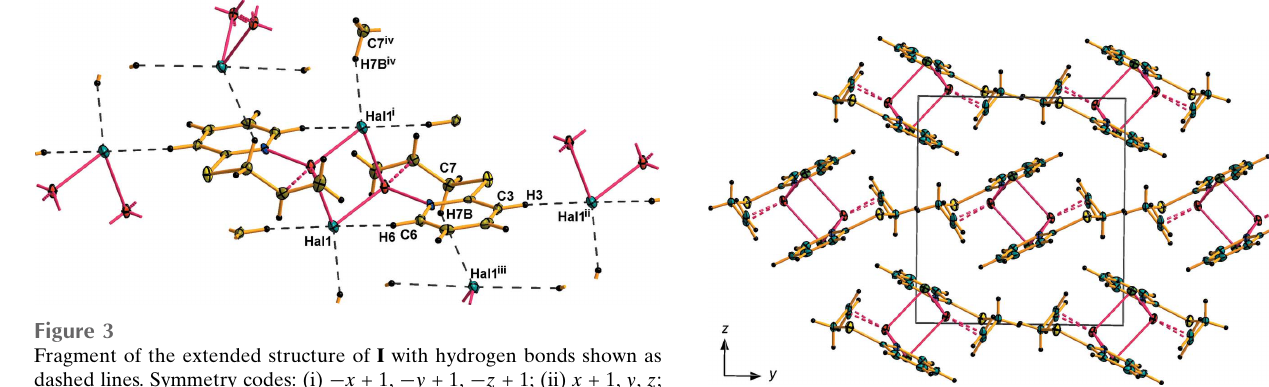
Figure 4 A view along the a- axis direction of the crystal packing of I .